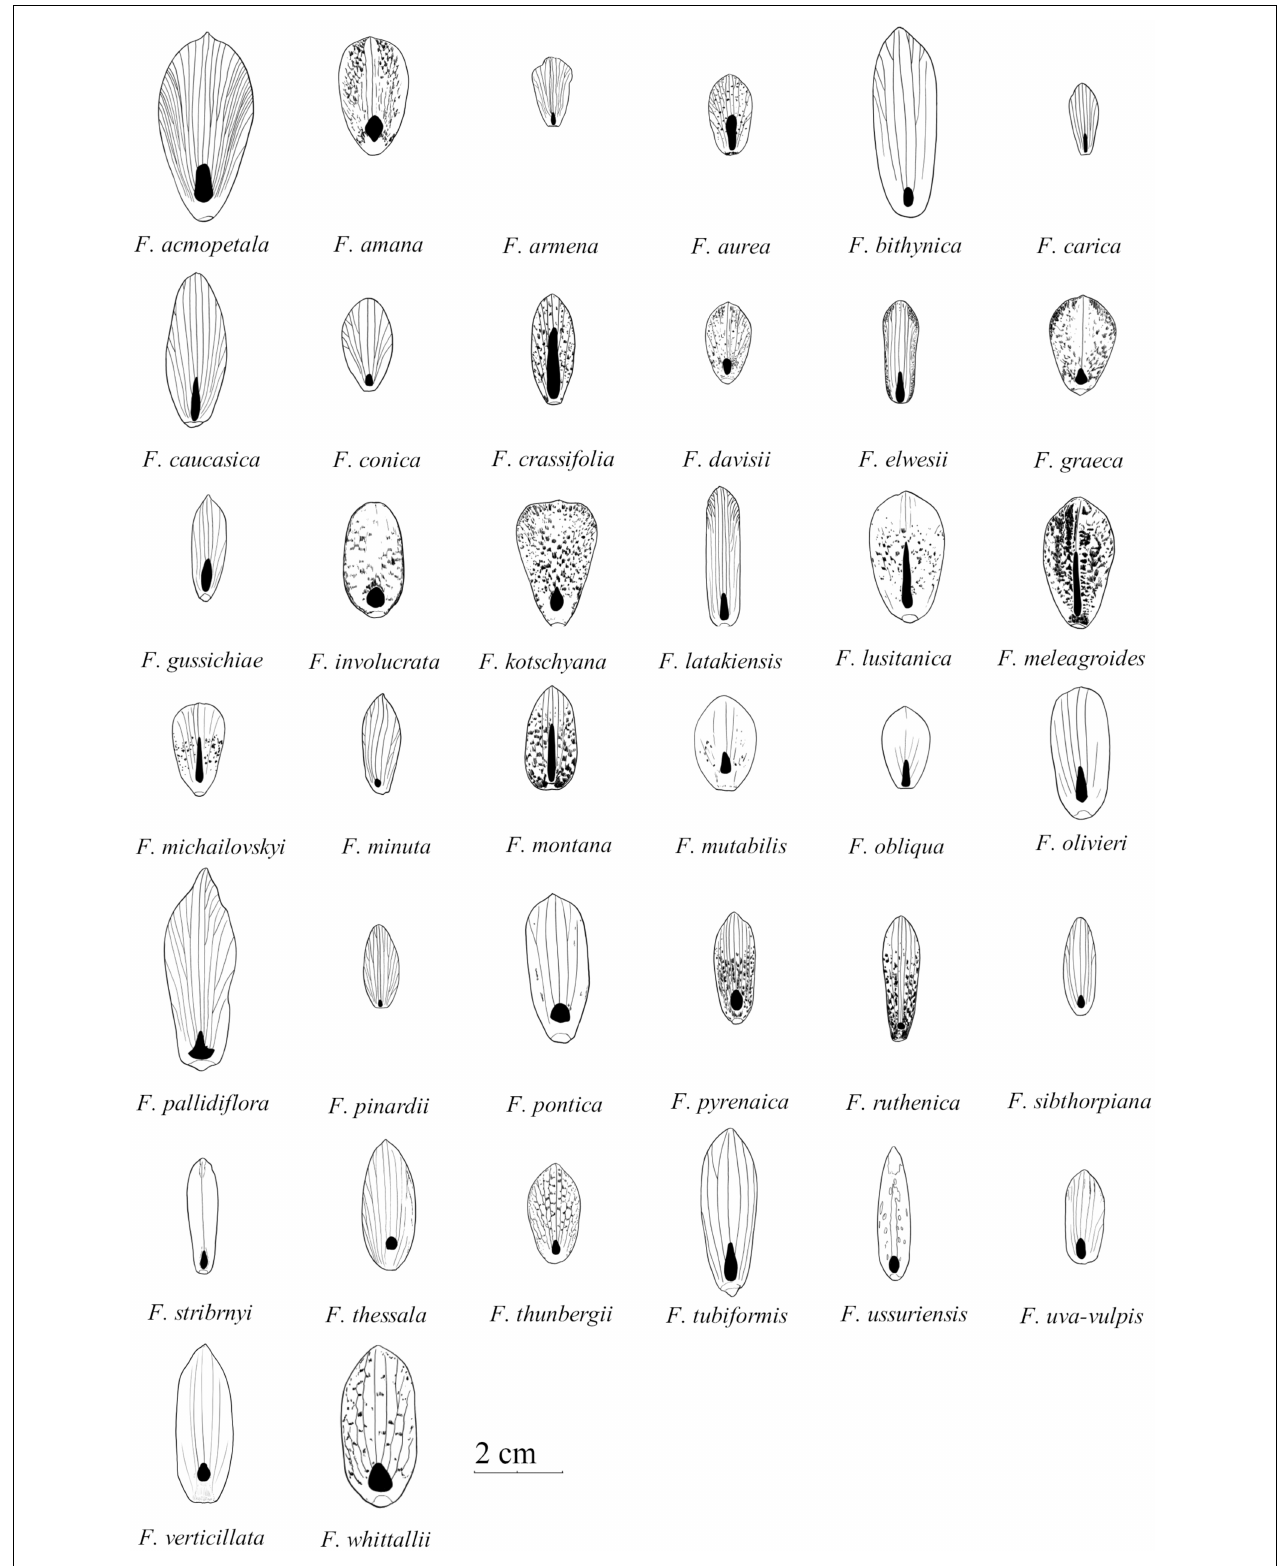
FIGURE 1 | Schematic drawings of outer tepals and nectaries (filled with black) in species studied of the subgenus Fritillaria . Size graded according to natural size of studied tepals (Drawn by Jan Kryci´nski).